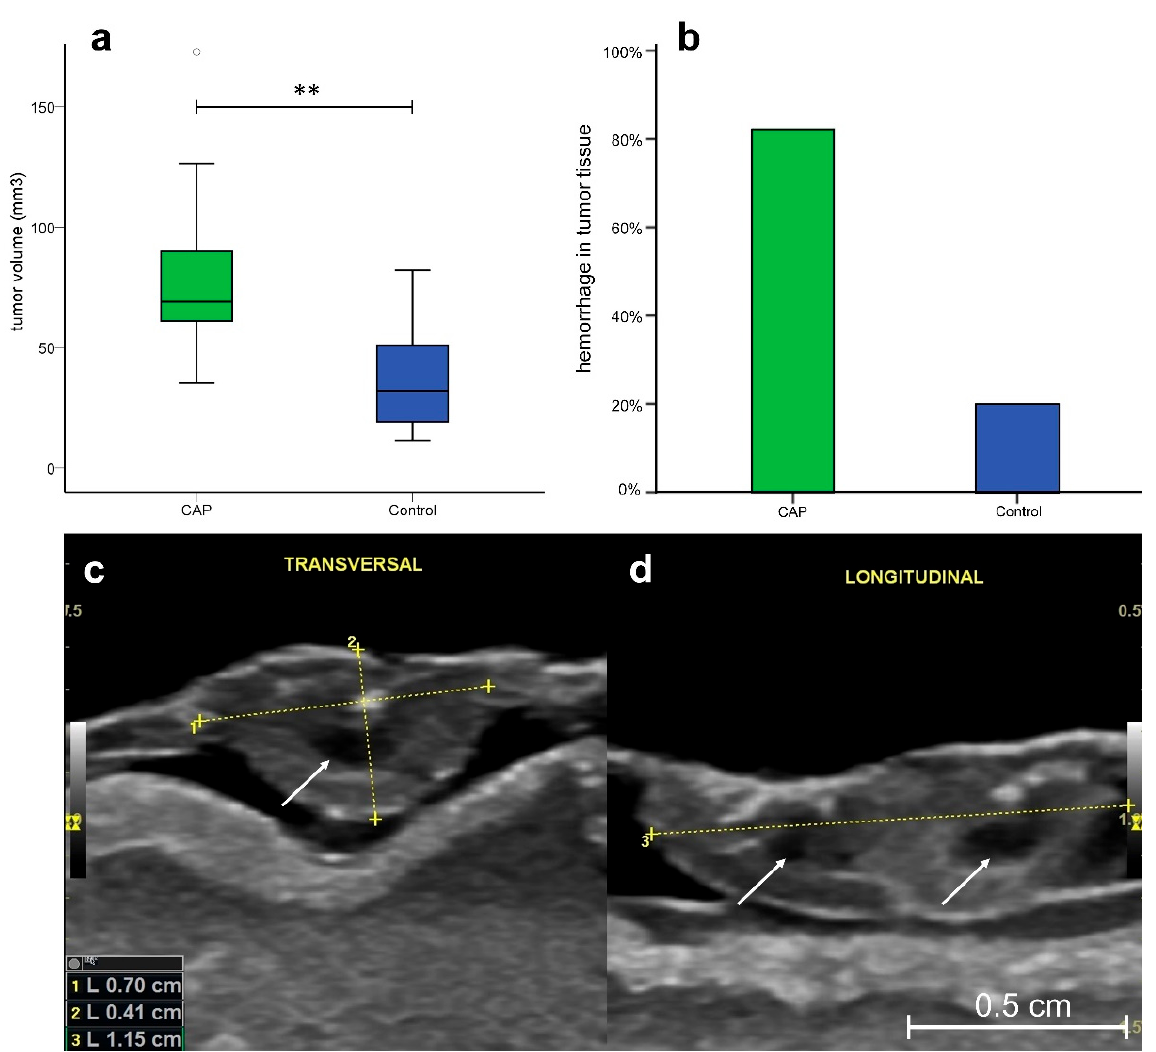
Figure 5. Ultrasonographically assessed tumor volume and hemorrhages. ( a ) Boxplot of tumor volume in specimens after CAP or sham treatment (CAP: n = 17, Median = 69.1, IQR = 31.9; sham: n = 15, Median = 32.1, IQR = 33.9). CAP-treated tumors demonstrated significantly increased tumor volume compared to untreated tumors ( p < 0.01); ( b ) Intratumoral hemorrhage was observed in 82.4% of CAP-treated tumors and 20% of sham-treated tumors; ( c ) Ultrasonographic image of the inoculated tumor in CAM in the transversal axis ( d ) and the longitudinal axis. Scale bar length 500 µm. Arrows indicate intratumoral hemorrhage. ** p < 0.01.